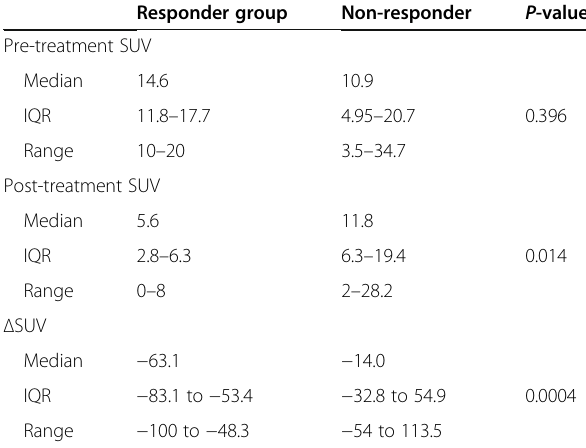
Table 3 Comparison between pre-treatment SUV, post- treatment SUV, and % change in SUV ( Δ SUV) of the responder and non-responder groups